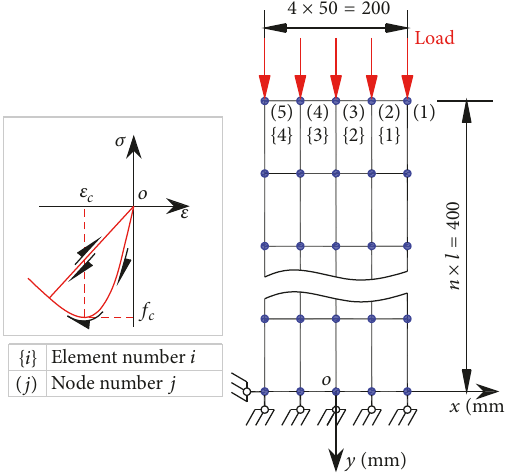
Figure 2: Geometry, meshing, and illustration of uniaxial compres- sion stress-strain relation of Model